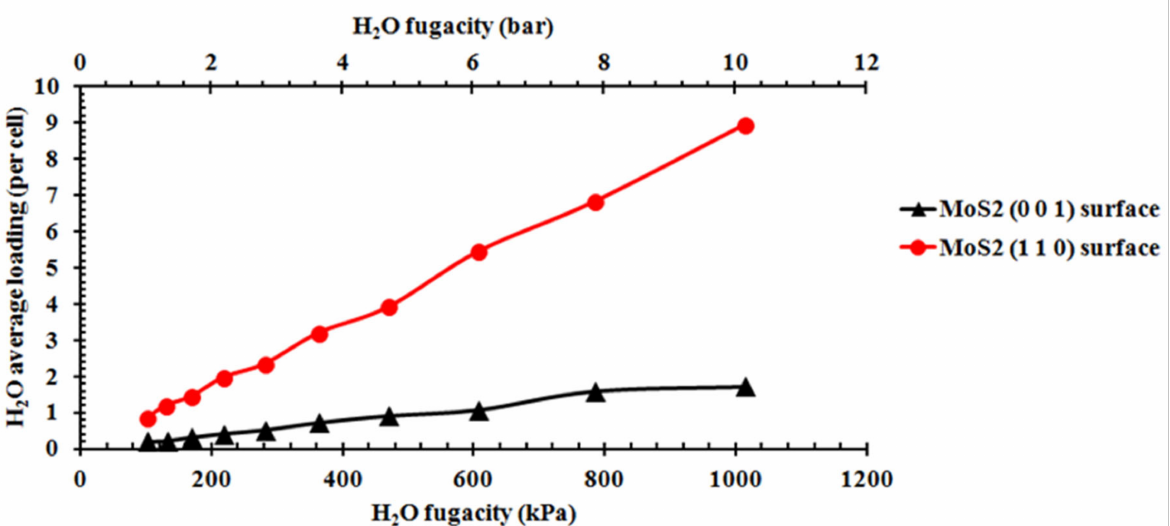
Figure 5. Sorption capacity change of H 2 O on the (001) and (110) surfaces of MoS2 at 1 and 10